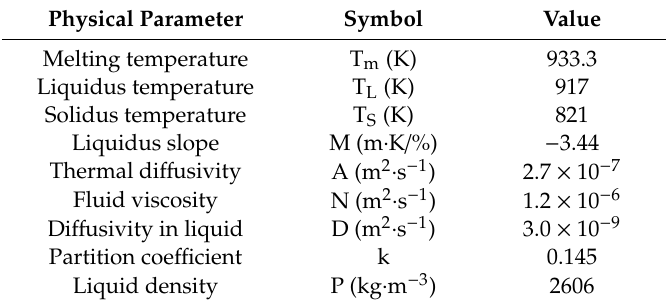
Table 1. Physical properties of Al-4.7% Cu